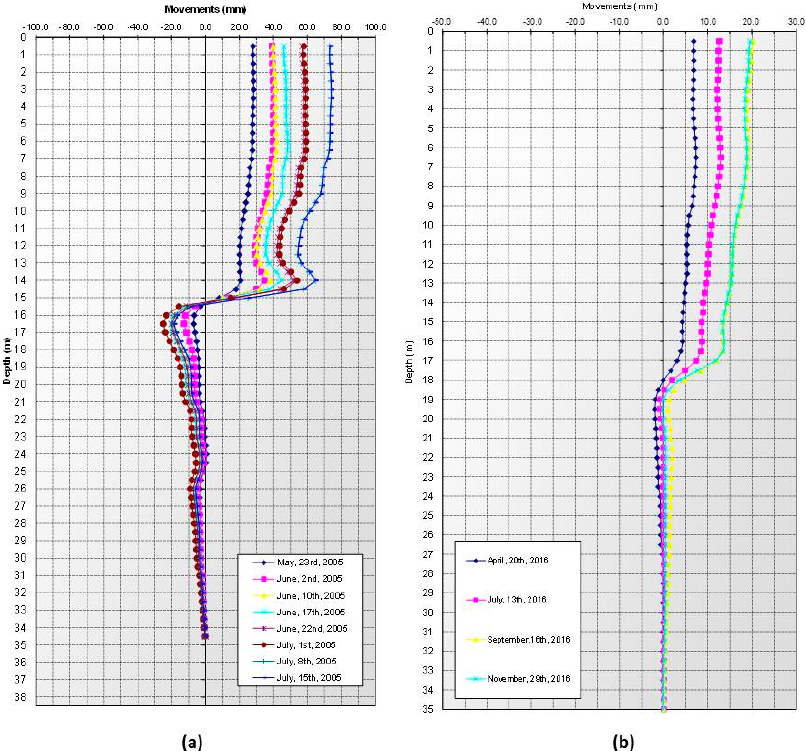
Figure 7. Inclinometers records: ( a ) Inclinometer placed in borehole B-5, reprinted with permission from ref. [15], Copyright Year 2005, Copyright Owner’s F.J. Torrijo (old geotechnical investigations [15], conducted in 2005); ( b ) Inclinometer placed in borehole B-9 (new geotechnical investigations, conducted in 2016).